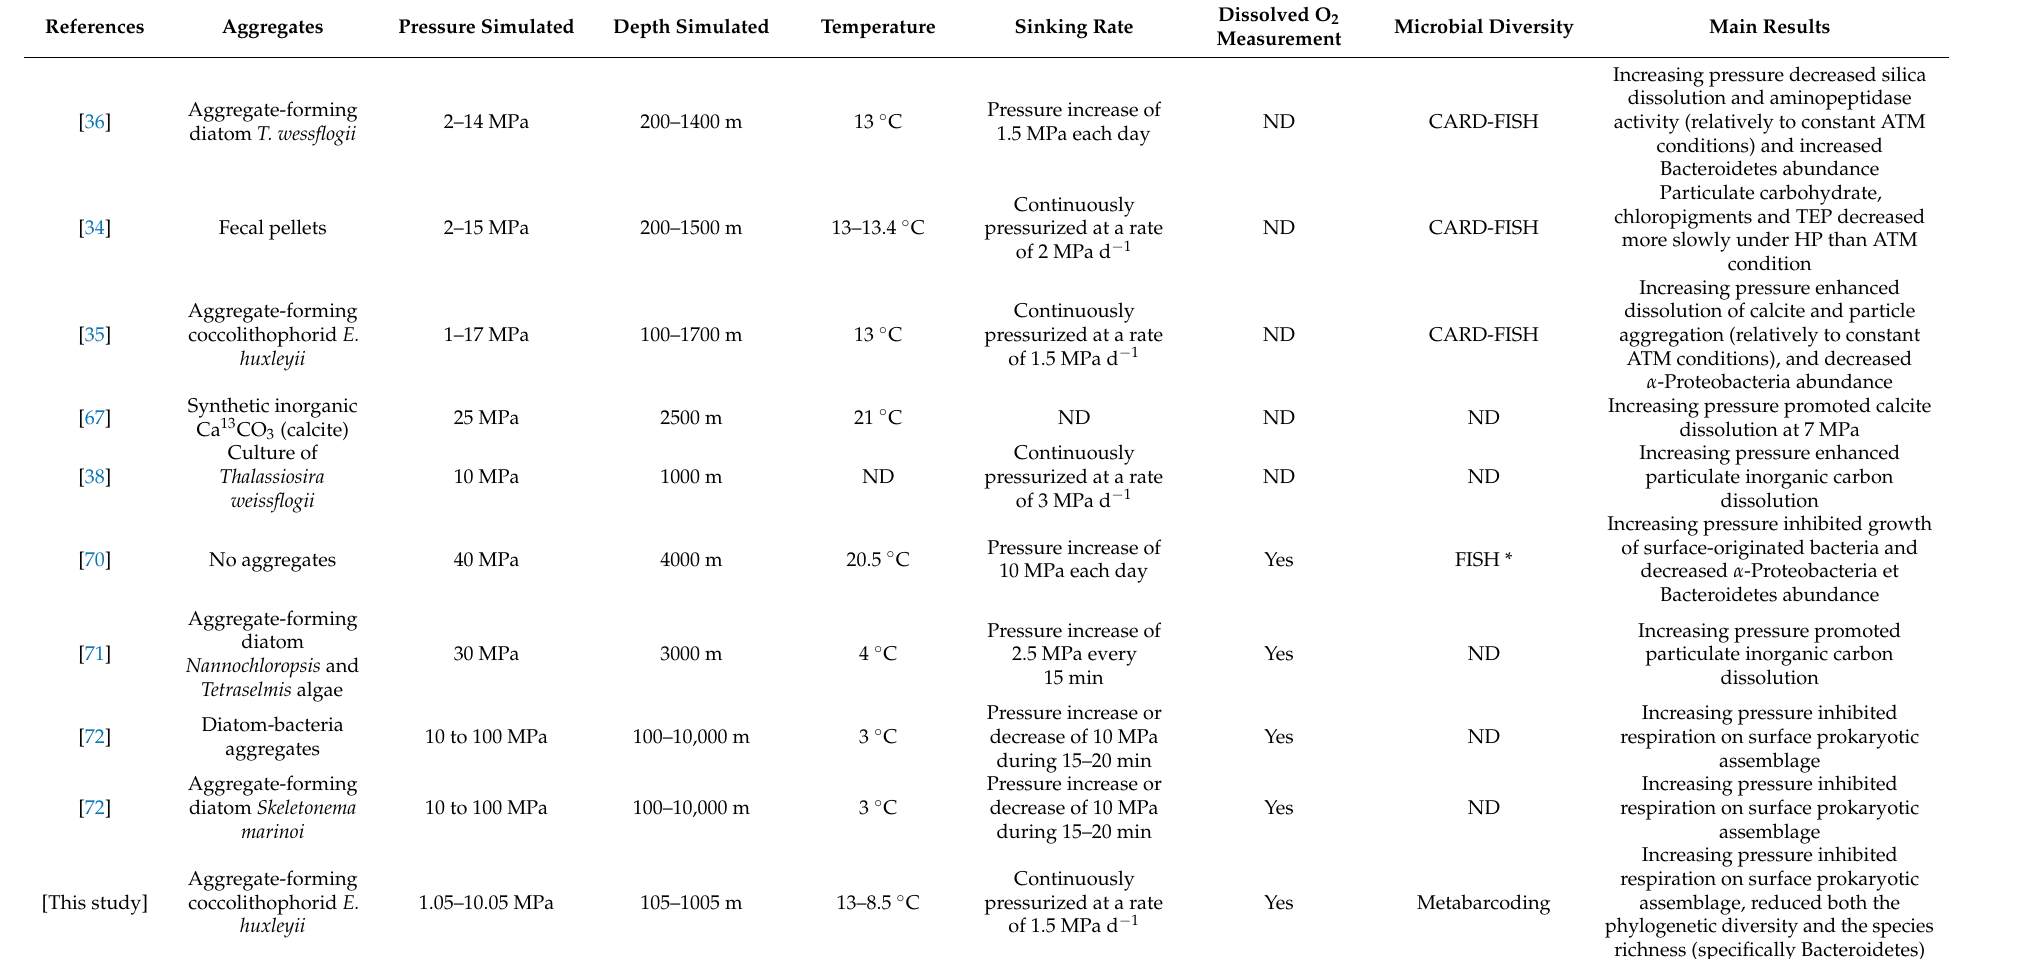
Table 1. Main results from literature reporting similar experiments performed with the surface prokaryotic community. ND: not